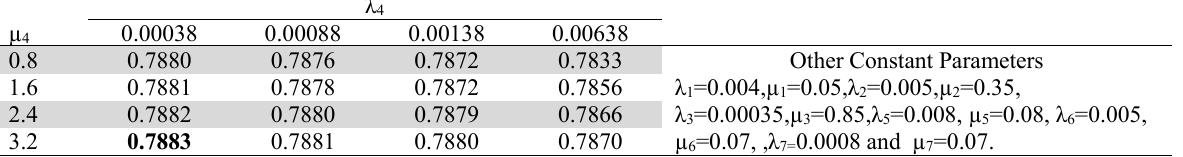
Effect of failure and repair rates of case packer machine on system availability λ